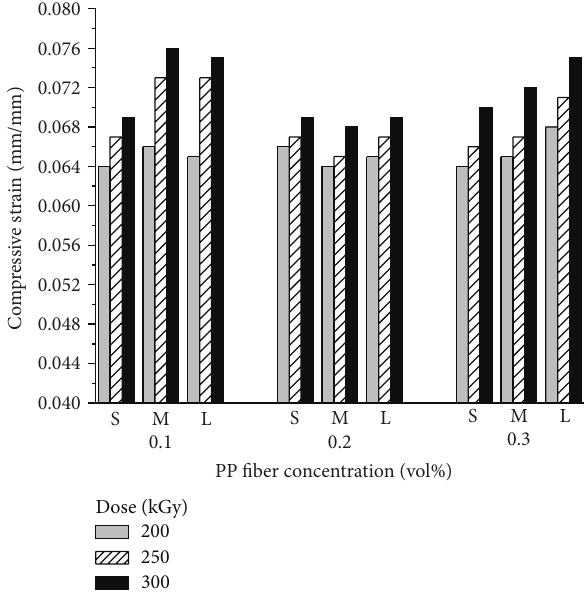
Figure 4: Compressive strain of irradiated-polymer concrete with different marble particle sizes and fiber concentrations.